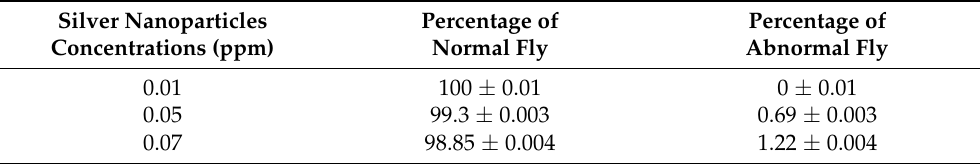
Table 2. Toxic effect of silver nanoparticles at different concentrations on development stage of Drosophila melanogaster